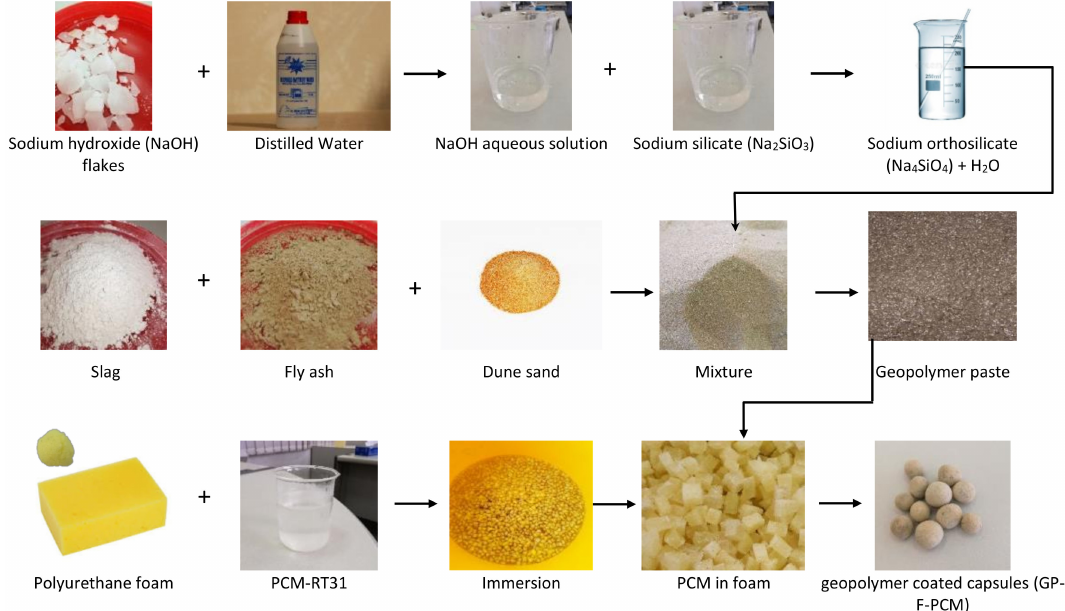
Figure 1. Photographs of the raw materials and the process of development of PCM